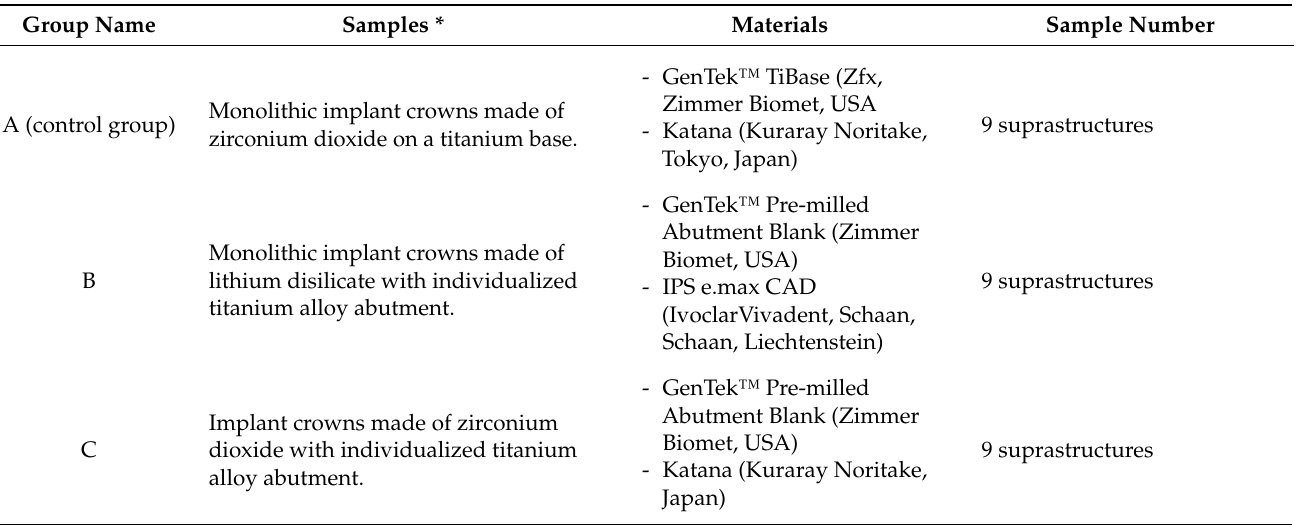
Table 3. The three study groups according to the